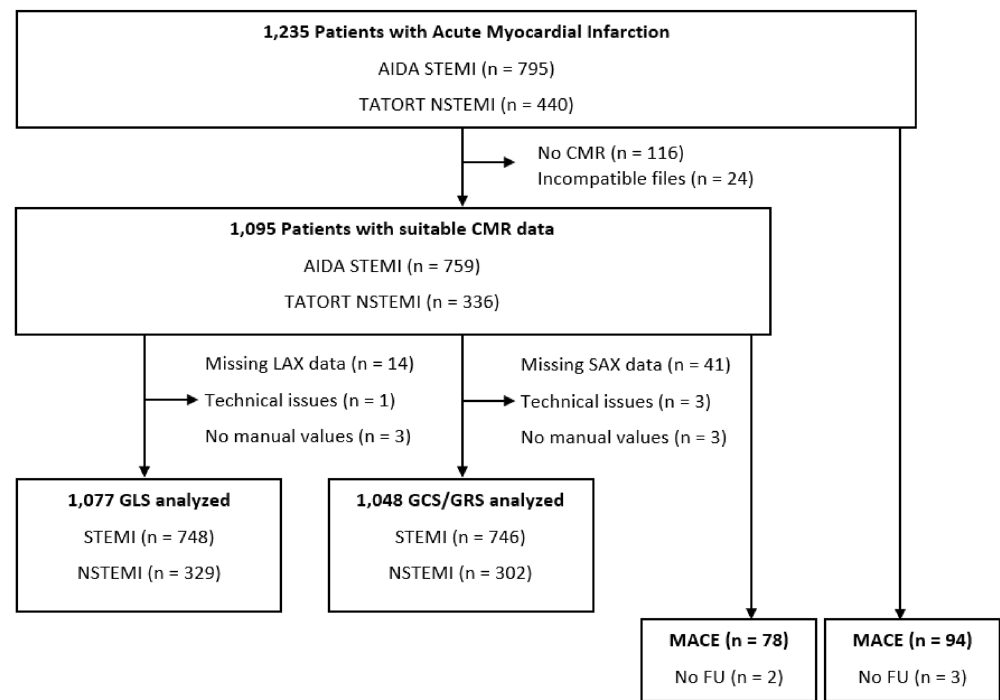
Figure 1. Flow chart of study data. AIDA STEMI, Abciximab i.v. versus i.c. in ST-elevation Myocardial Infarction; CMR, cardiac magnetic resonance; FU, follow-up; MACE, major adverse cardiac events; NSTEMI, non-ST-segment–elevation myocardial infarction; STEMI, ST-segment–elevation myocardial infarction; and TATORT NSTEMI, Thrombus Aspiration in Thrombus Containing Culprit Lesions in Non-ST-Elevation Myocardial